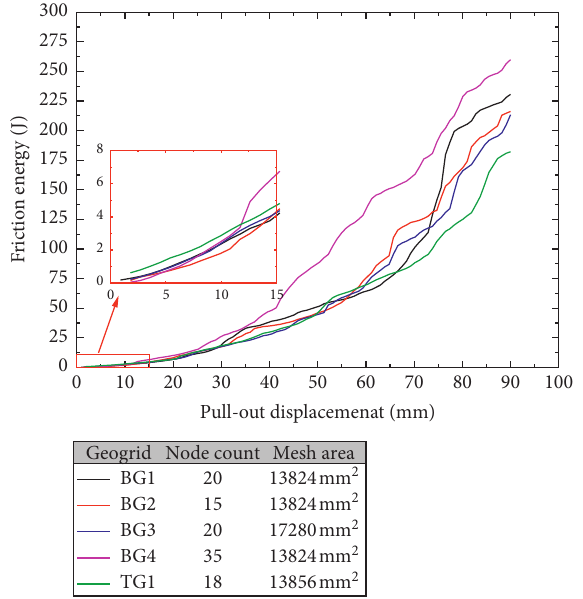
Figure 13: Frictional energy dissipation of the particle system against the pull-out displacement under 50kPa normal